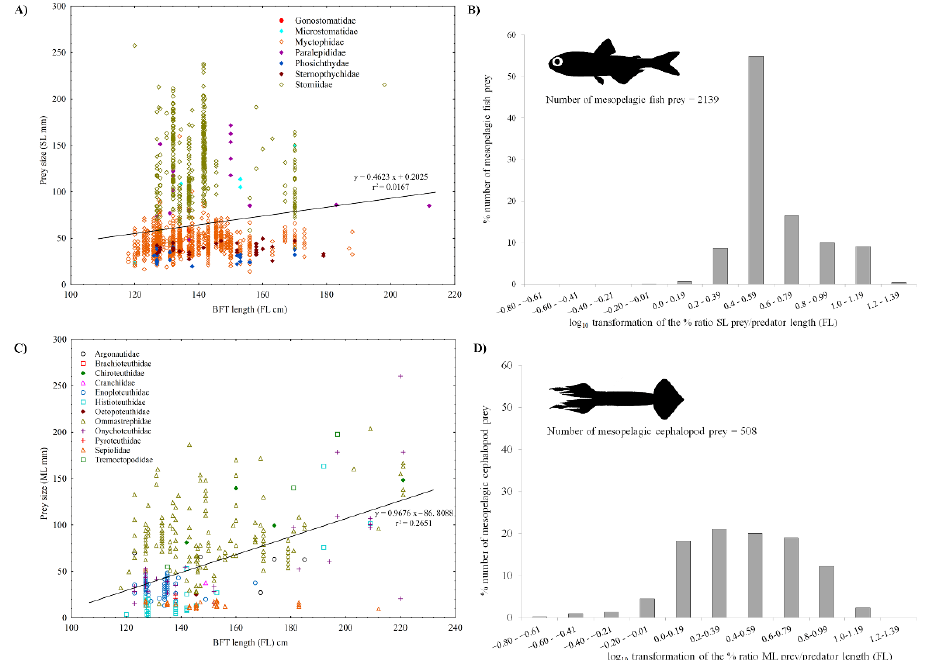
Figure 7. Relationship between the BFT fork length (FL cm) and the size of mesopelagic fish ( A ) and cephalopod ( C ) prey. Standard length (SL mm) and mantle length (ML mm) were considered for fish and cephalopod food items, respectively. Linear regression equations are also given. The histograms in ( B , D ) show the log10 transformation of the percent ratio between mesopelagic prey length and tuna fork length, for fish and cephalopods, respectively.